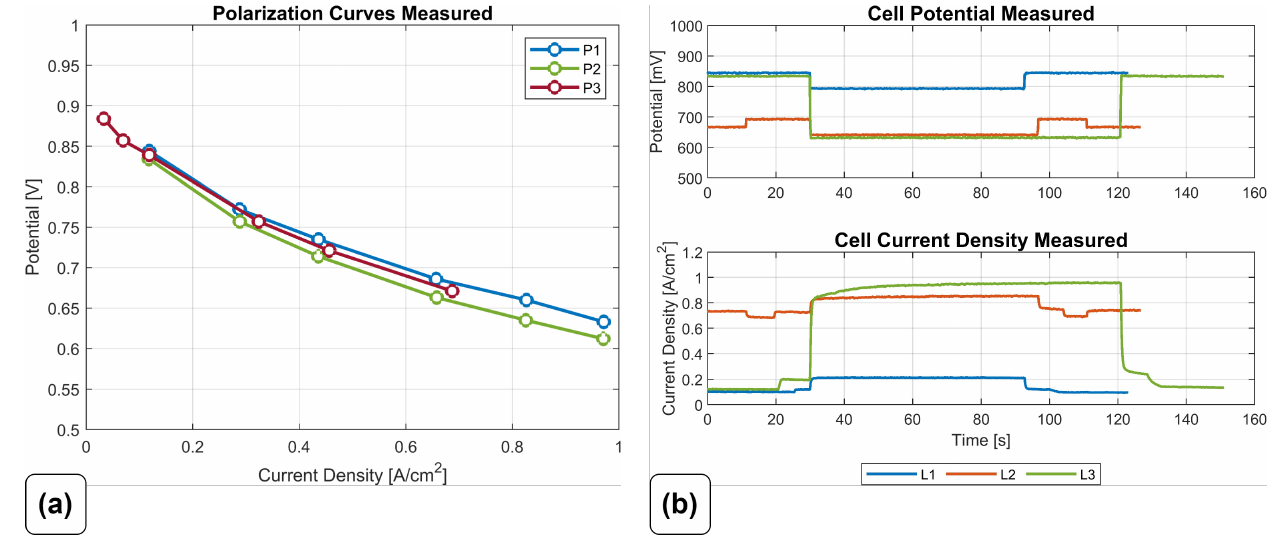
Figure 5. ( a ) Measured polarization curves with current-driven fuel cell. ( b ) Measured load steps with voltage-driven fuel cell. Reprinted from